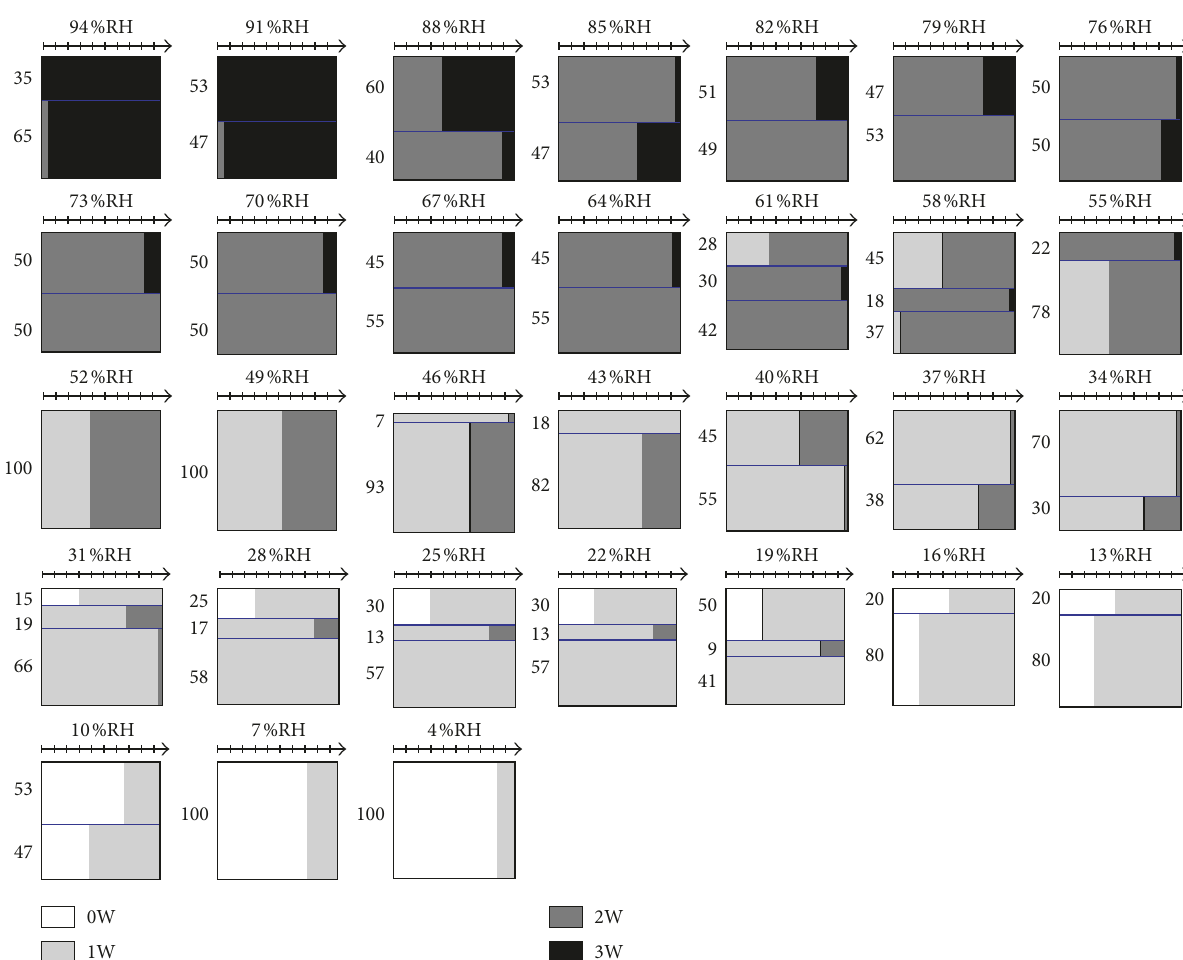
Figure 4: Schematic representation of the structure model used to fit the experimental XRD pattern in the case of the unstressed sample along the desorption